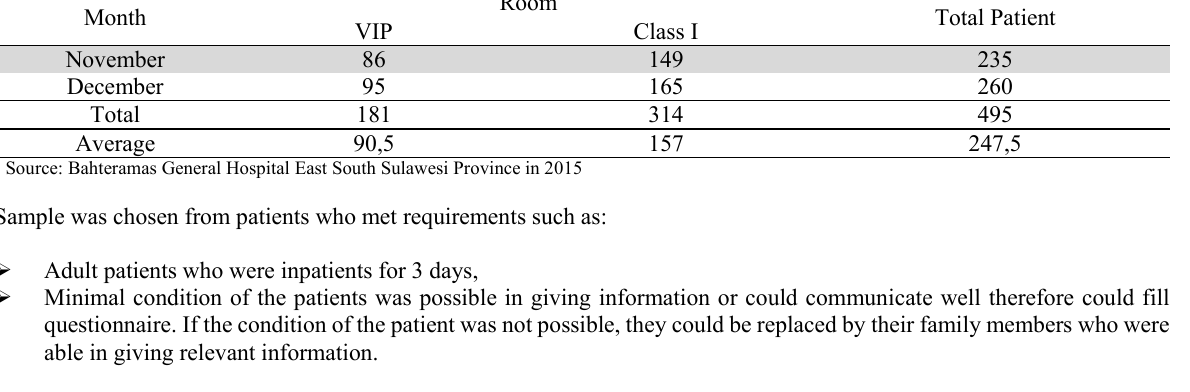
Total Inpatient of Bahteramas General Hospital South East Sulawesi Province in the Last Two Months Room Month VIP Class I